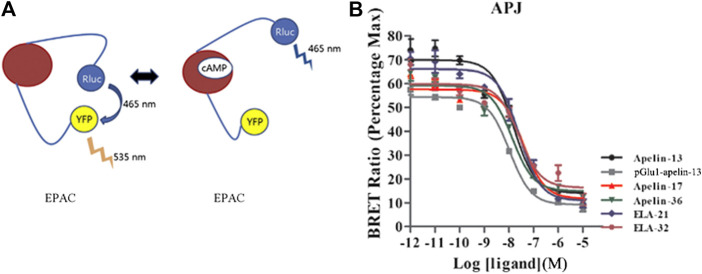
Intracellular cAMP production induced by the six agonists. (A) A schematic diagram of YFP-cAMP-Rluc fusion expression vector. (B) In HEK293 cells stably expressing APJ, the cAMP dose-response curve was measured at 20 min after stimulation with six peptide. p < 0.05 was considered as statistically significant. Data represent mean ± SEM from four independent experiments (Supplementary Table S1).